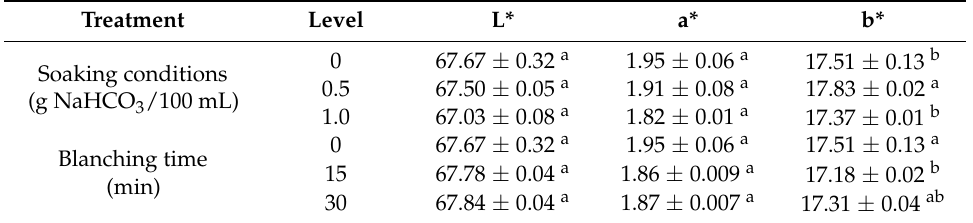
Table 3. Color analysis of millet milk influenced by production